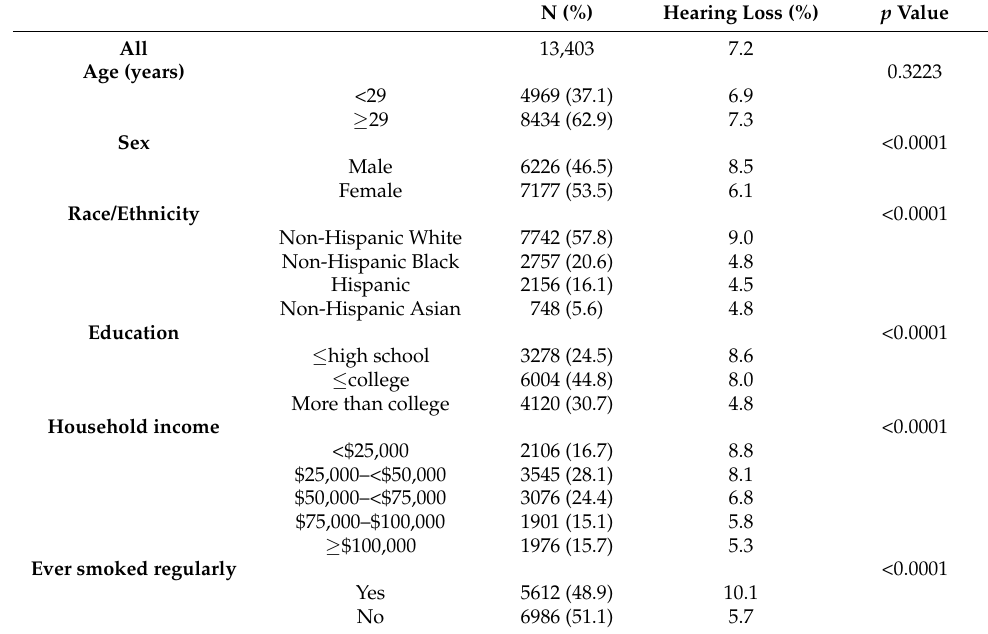
Table 1. Prevalence of hearing loss by socio-demographic characteristics and smoking status.